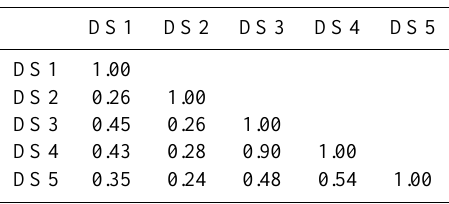
Table 7. Correlation matrix of the linear correlation coefficients (Pearson coefficients) for the final five susceptibility maps, raw